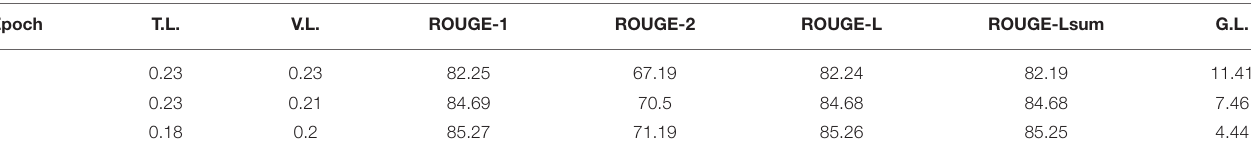
TABLE 7 | Fine-tuning T5 based on Equation 3.